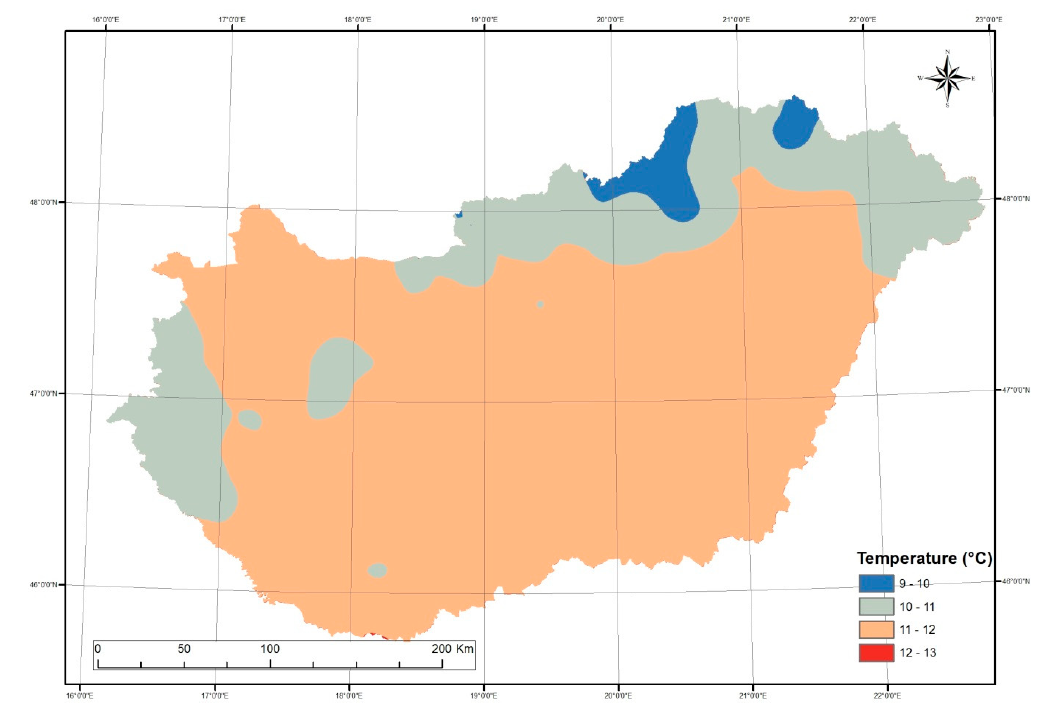
Figure 2. Distribution of thirty-year average temperature for the period of 1961–1990 based on the CARPATCLIM data- base.